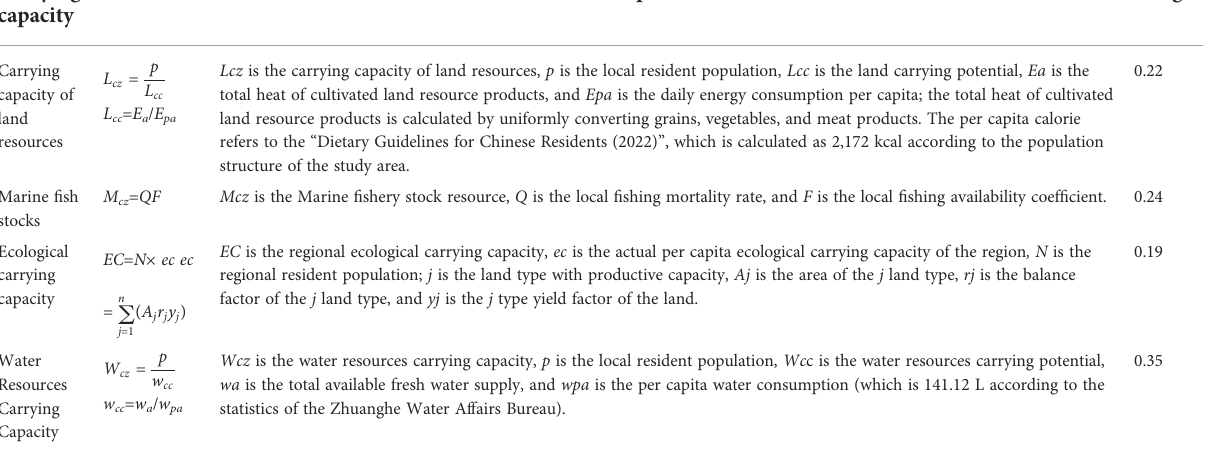
TABLE 3 Evaluation index of marine resource and environmental carrying capacity in